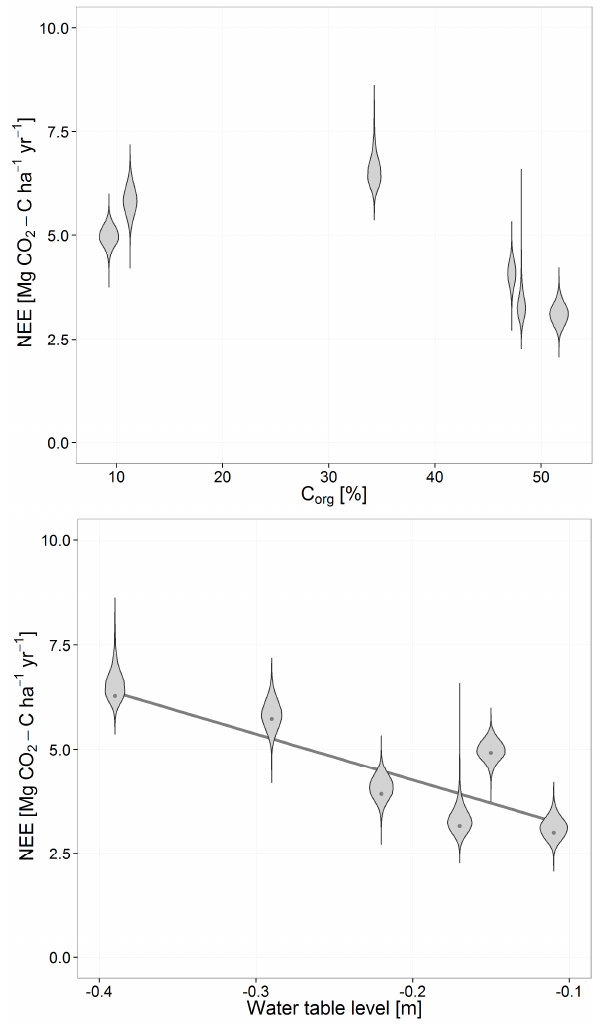
Fig. 4. Violin plots of NEE emissions vs. C org ( A ; R 2 = 0 . 49, p = 0 . 121) and NEE emissions vs. water table level ( B ; R 2 = 0 . 71, p = 0 . 035). Violins (A, B) : distribution of all simulated aggregated annual NEE sums of each site; points (B) : modelled annual NEE of each site, used as basis for linear regression.